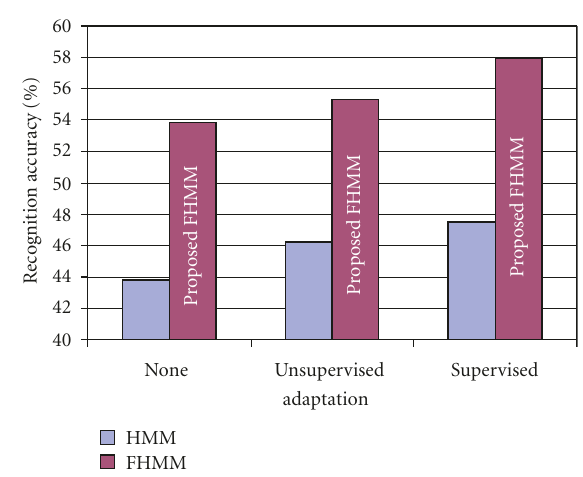
Figure 10: Averaged results of home-environment